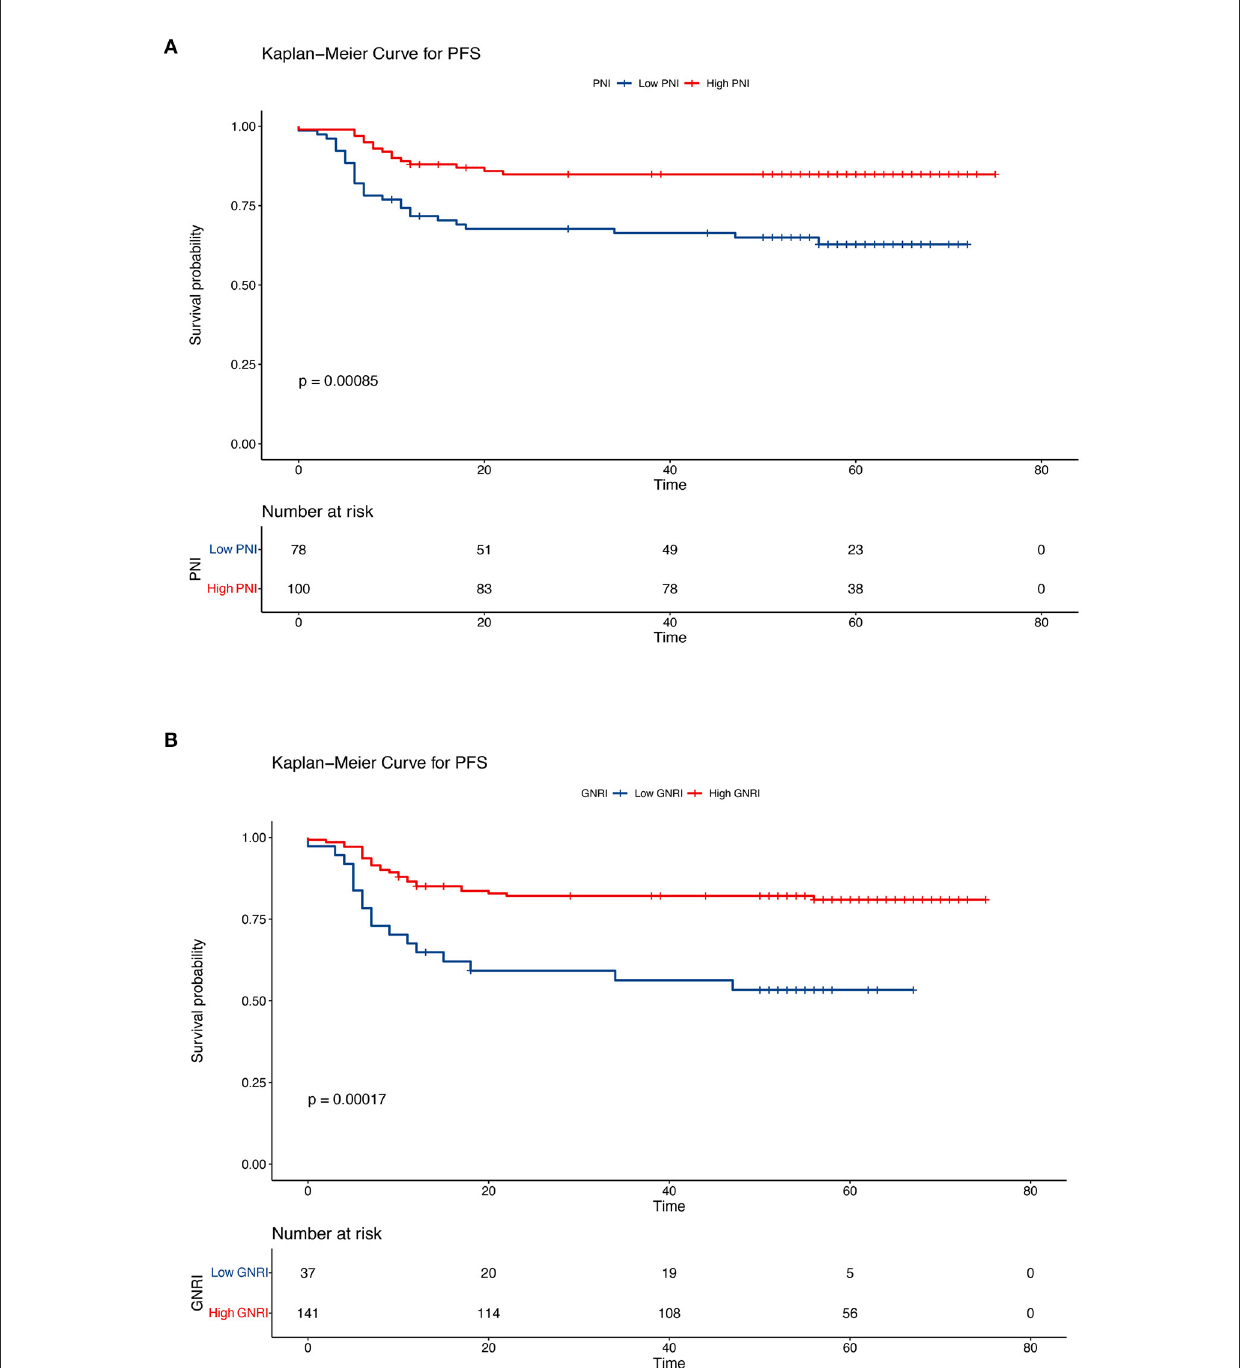
FIGURE4 Kaplan–Meier curves of progression-free survival according to the nutritional indicators. (A) Low prognostic nutritional index (PNI) vs. high PNI (low PNI: ≤ 48.3, high PNI: > 48.3) and (B) low geriatric nutritional risk index (GNRI) vs. high GNRI (low GNRI: ≤ 97.04, high GNRI: > 97.04). The Kaplan–Meier method was used to calculate the survival rate, and the log-rank test was used to compare survival distributions between the